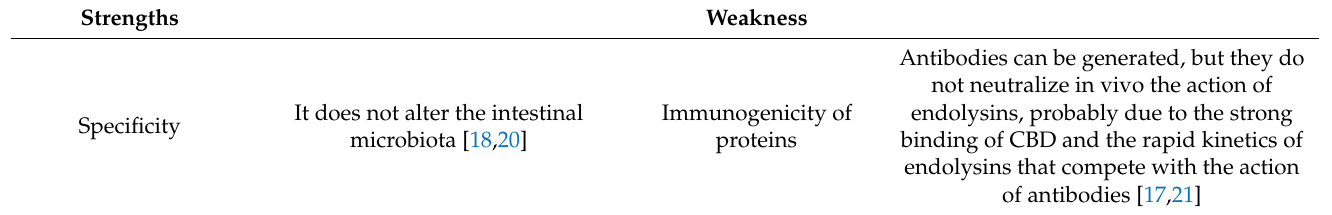
Table 1. Strengths and weaknesses of endolysins based on their antimicrobial designation and protein